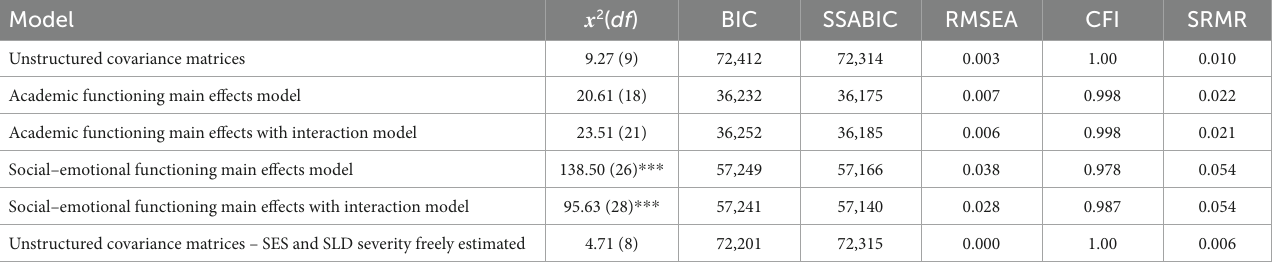
TABLE 5 Tests of measurement invariance for multilinguals and English monolinguals children. Model